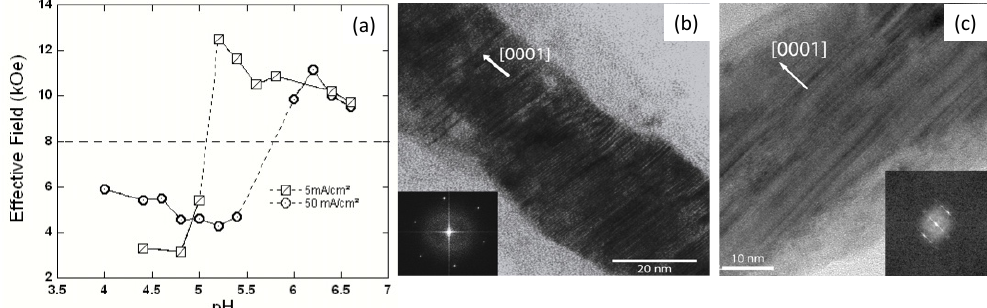
Figure 7. ( a ) effective field as a function of the pH for 30 nm Co nanowires electrodeposited at current densities of 5 mA/cm 2 (squares) and 50 mA/cm 2 (circles). The dashed line shows the expected value of H EF for an array of Co nanowires ( P 3.5%) assuming no contribution from magnetocrystalline ≈ anisotropy; ( b , c ) TEM images and corresponding diffraction patterns of two 30 nm Co nanowires electrodeposited at pH 5.2 at current densities of ( b ) 5 mA/cm 2 and ( c ) 50 mA/cm 2 (from [29]). Figure adapted from ref. [29] with permission of the